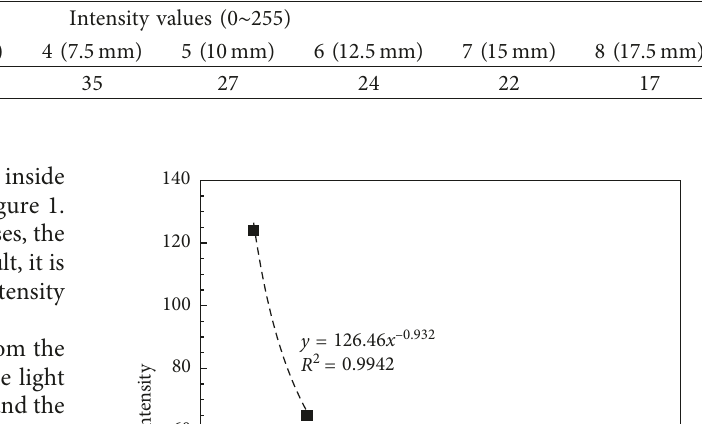
Table 4: Ideal experimental data.